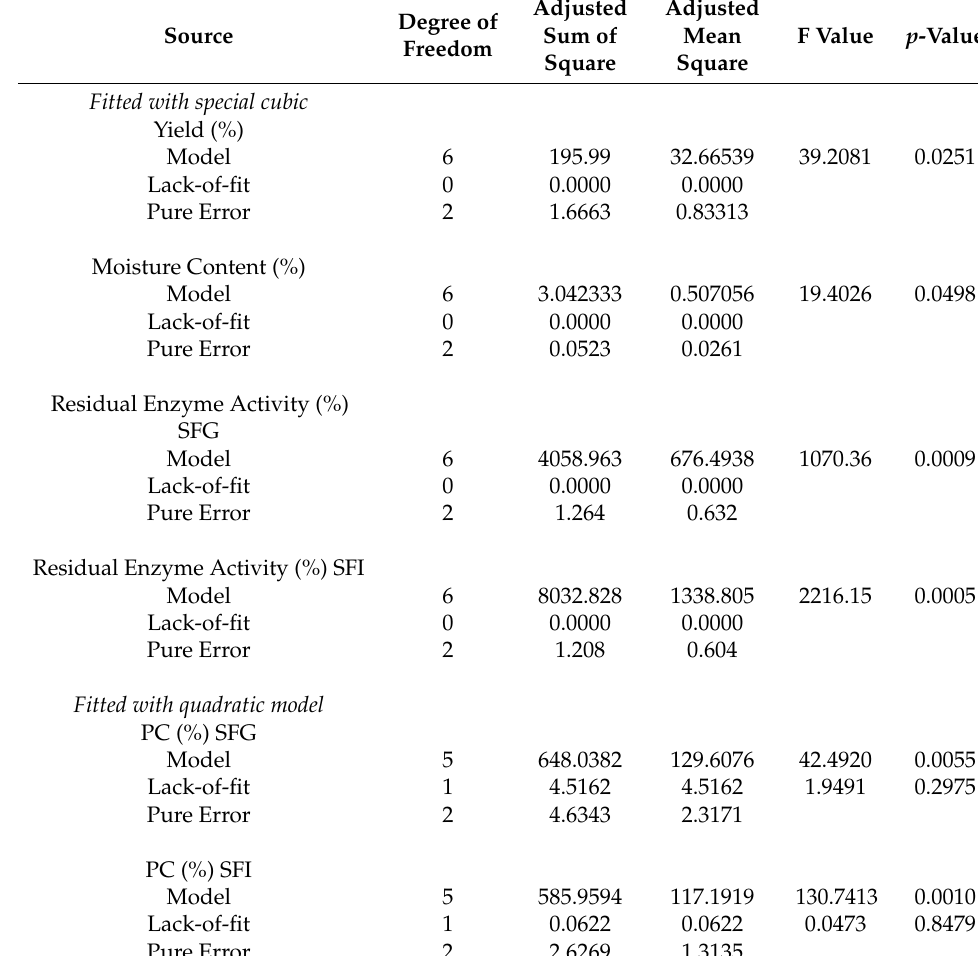
Table 3. Analysis of variance for the applied